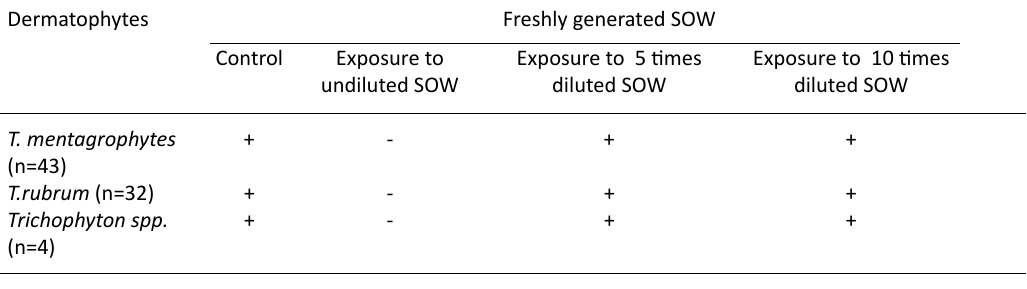
table1. Effect of SOW on different Trichophyton species isolated from superficial fungal infections Dermatophytes Freshly generated SOW Control Exposure to Exposure to 5 times Exposure to 10 times undiluted SOW diluted SOW diluted